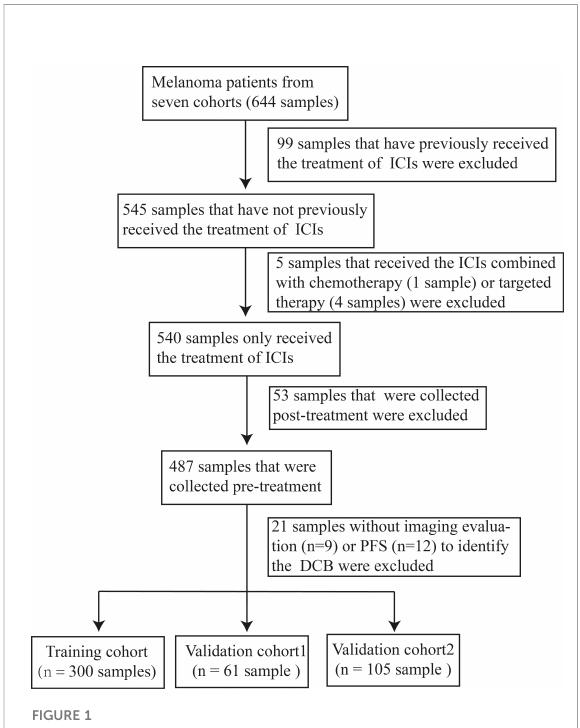
FIGURE 1 Sampling procedure for patients with melanoma treated with